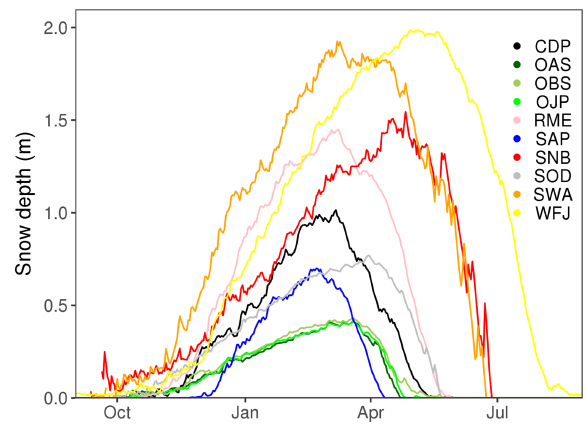
Figure 6. Daily climatological averages of snow depth measure- ments at all